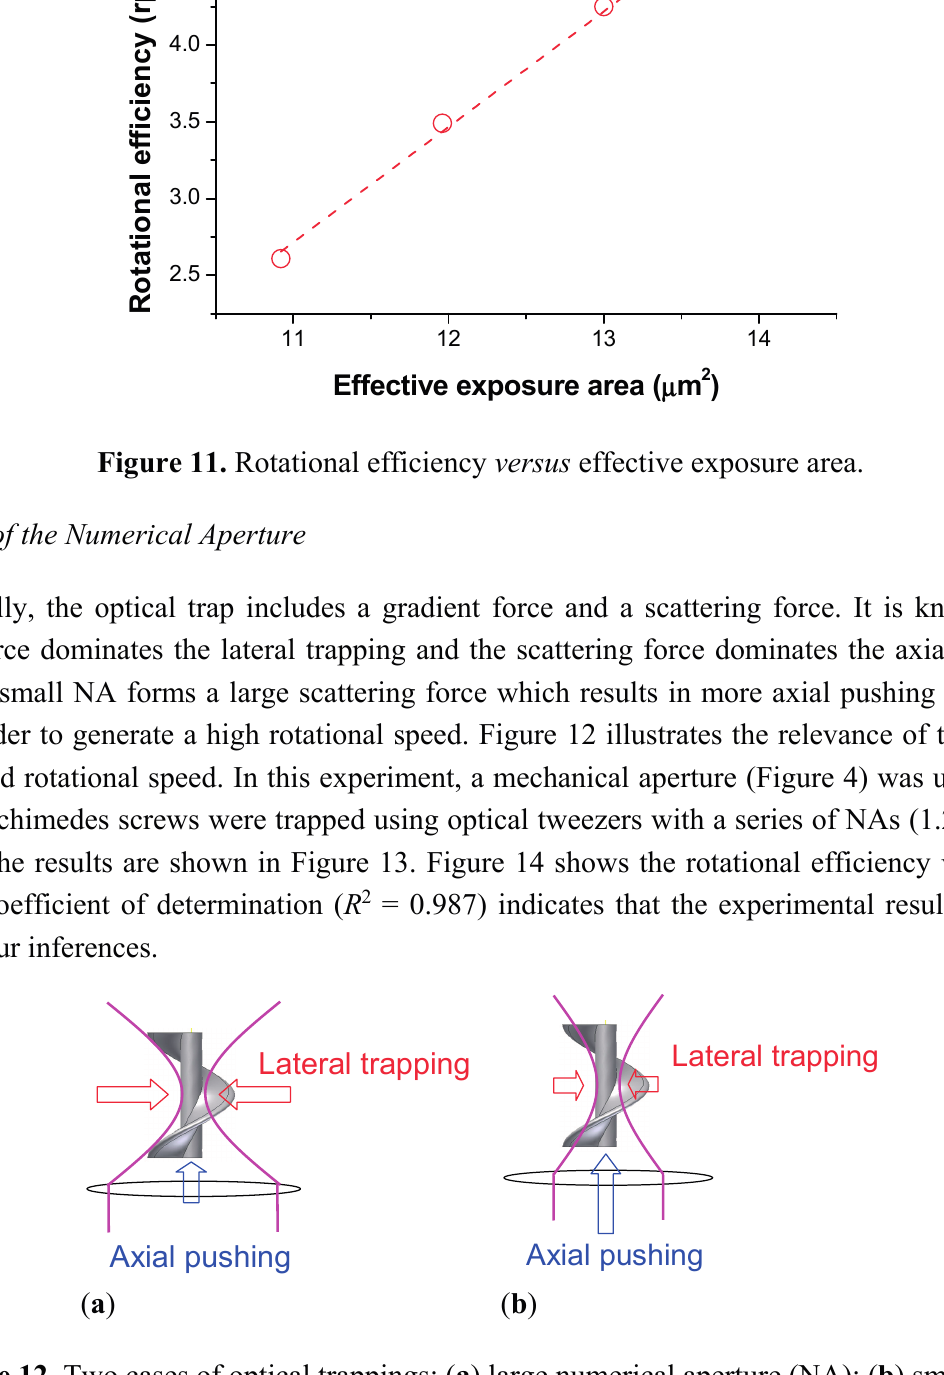
Figure 12. Two cases of optical trappings: ( a ) large numerical aperture (NA); ( b ) small